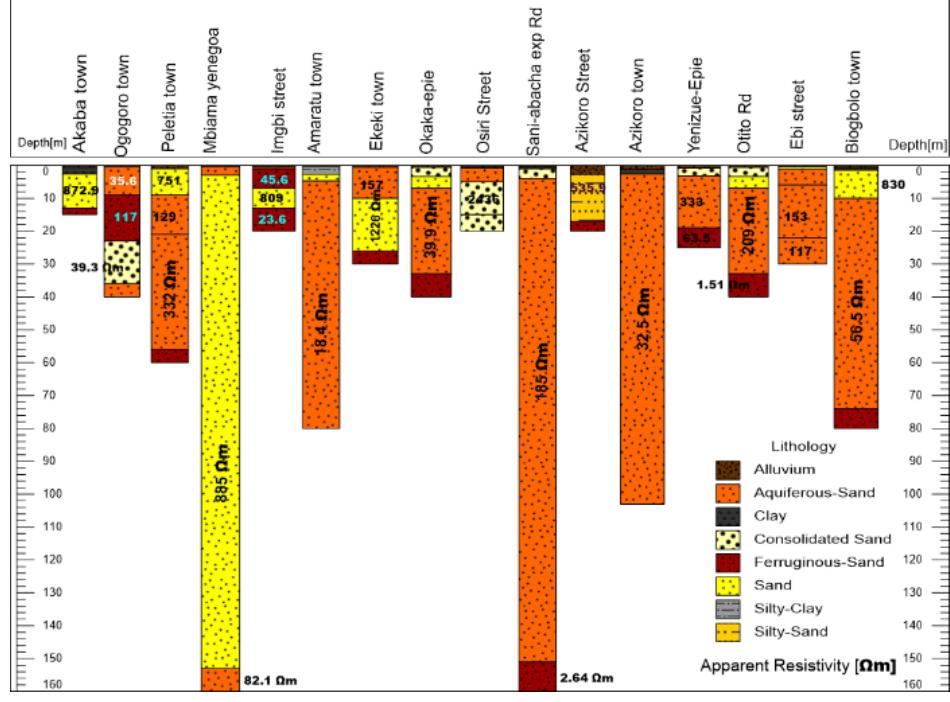
Figure 5: Geoelectric Section showing individual Station